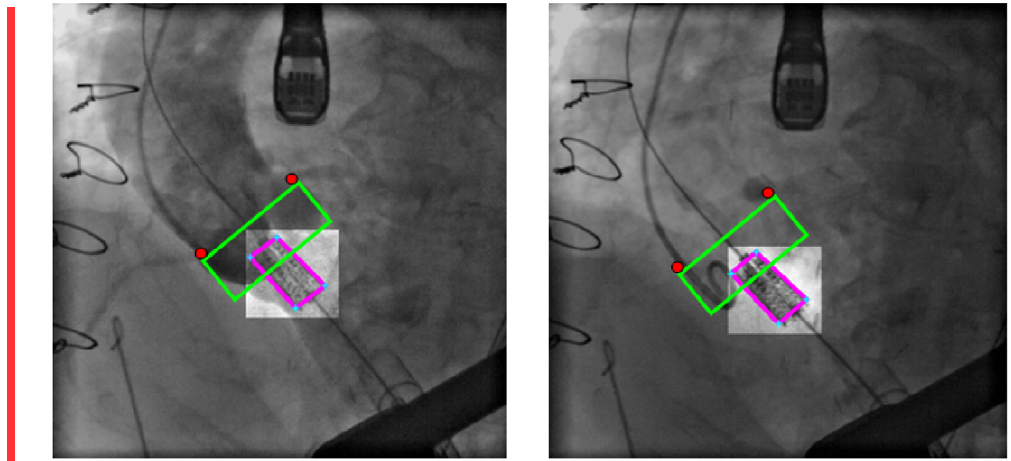
Figure. 10 Interoperative tracking of stented valve and coronary ostia (red dots with and without contrast agent [karar2010]. treatment for a patient in a cooperative manner. Appropriate image analysis and visualization tools can help in the formation of and communication within such interdisciplinary